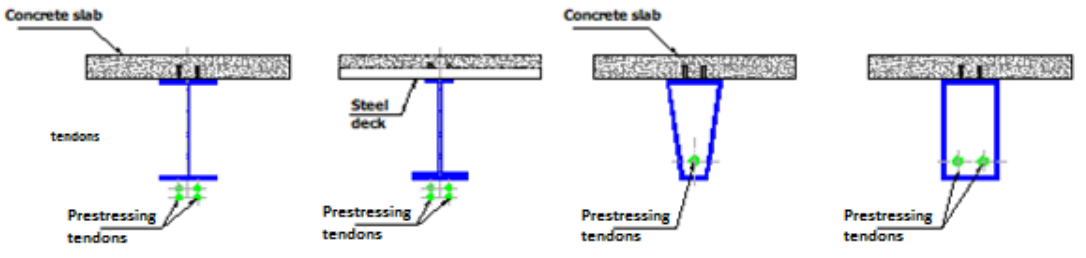
Figure 1. Possible profiles for external prestressing. Source: Troistky